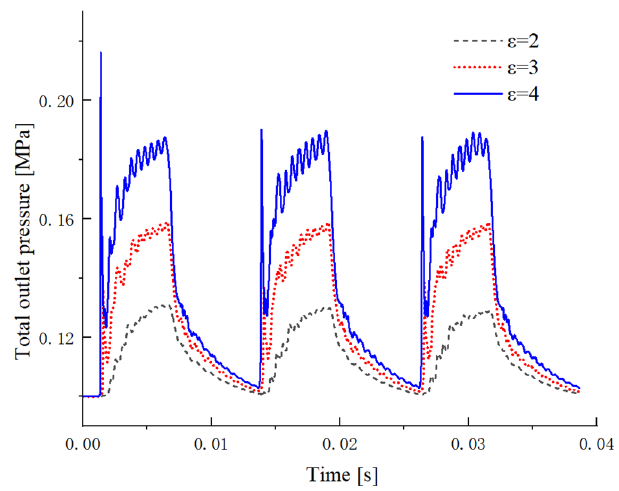
Figure 8. Outlet pressure change under different expansion ratios.